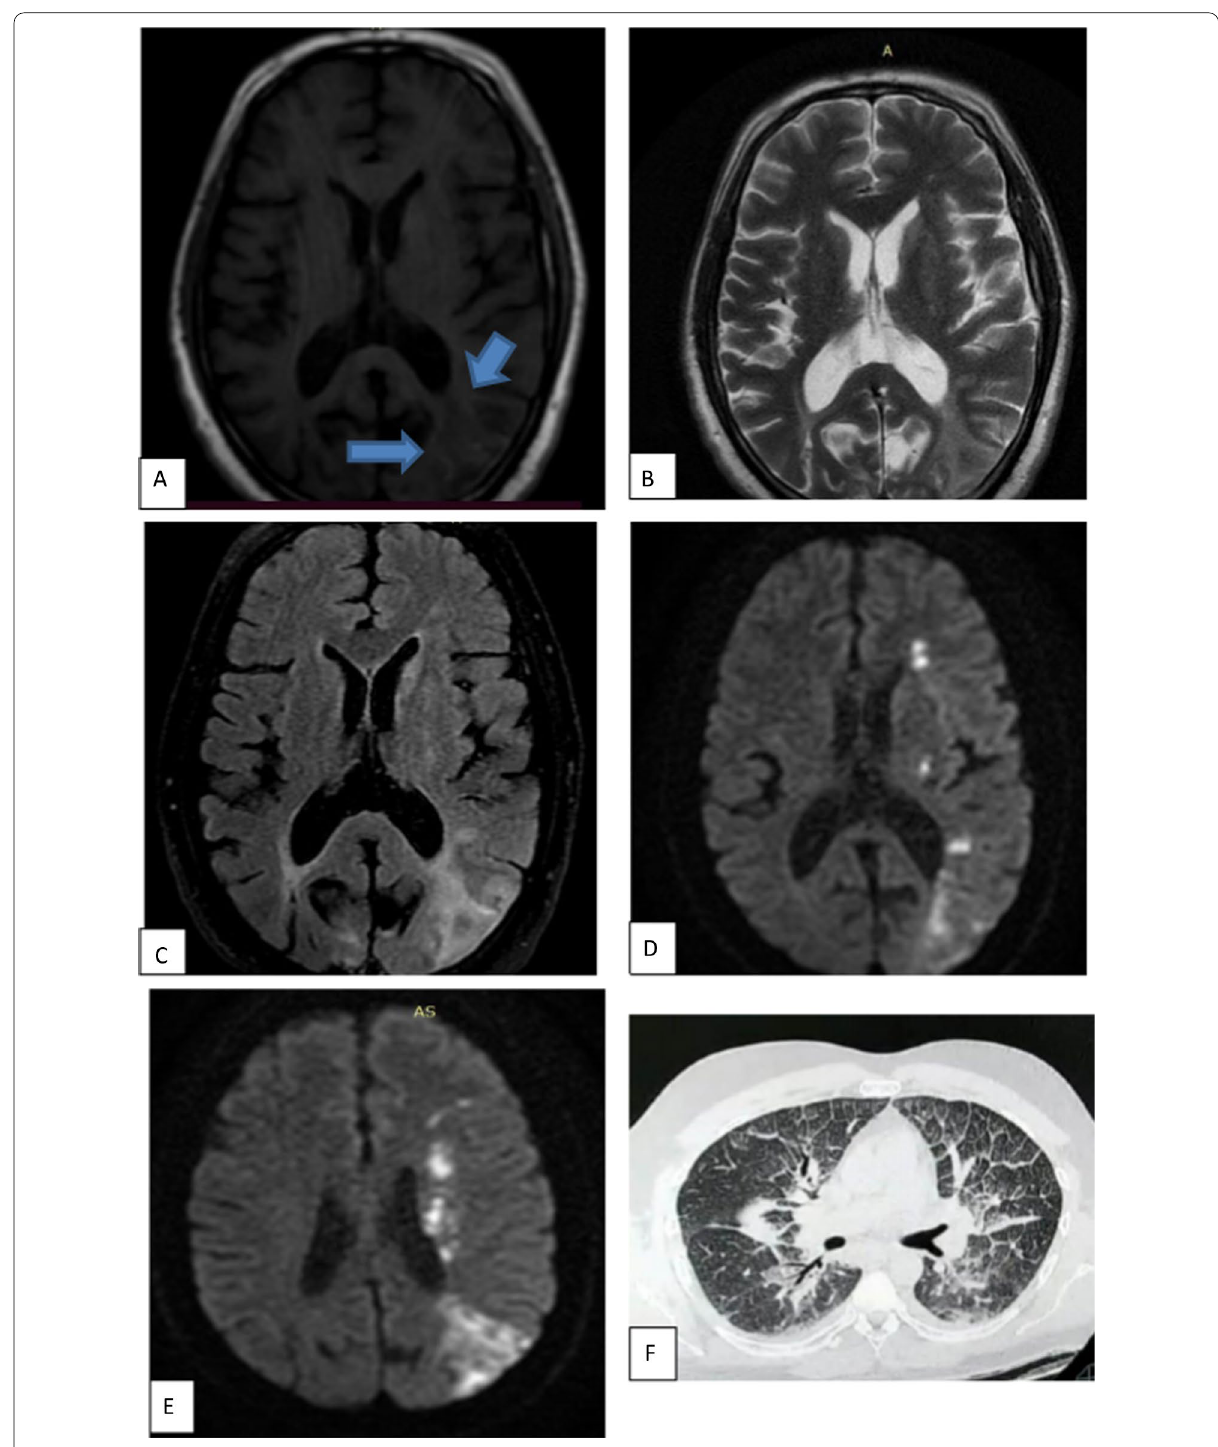
Fig. 2 A 43-year-old female patient presented with post COVID fatigue, followed by cerebrovascular stroke symptoms. MRI axial T1WI ( a ) revealed left occipital subcortical white matter abnormal signal display relative low signal intensity (arrow). Axial T2WI ( b ) show high SI with no mass effect. Axial FLAIR ( c ) showed corresponding increase signal intensity. DWI ( d , e ) showed areas of restricted diffusion. watershed infarcts with additional foci of lacunar infarcts. CT lung showed GGO very typical for COVID